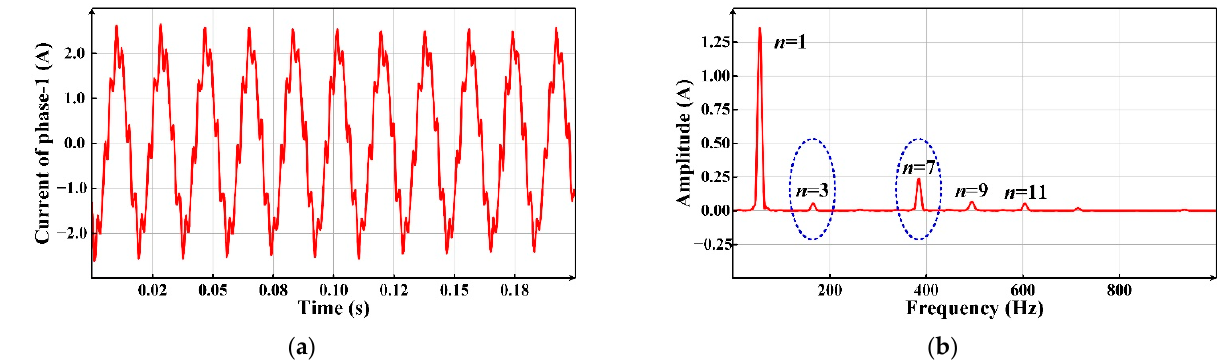
Figure 9. Harmonic current suppression results with fundamental currents: ( a ) phase-1 current; ( b ) DFT results.